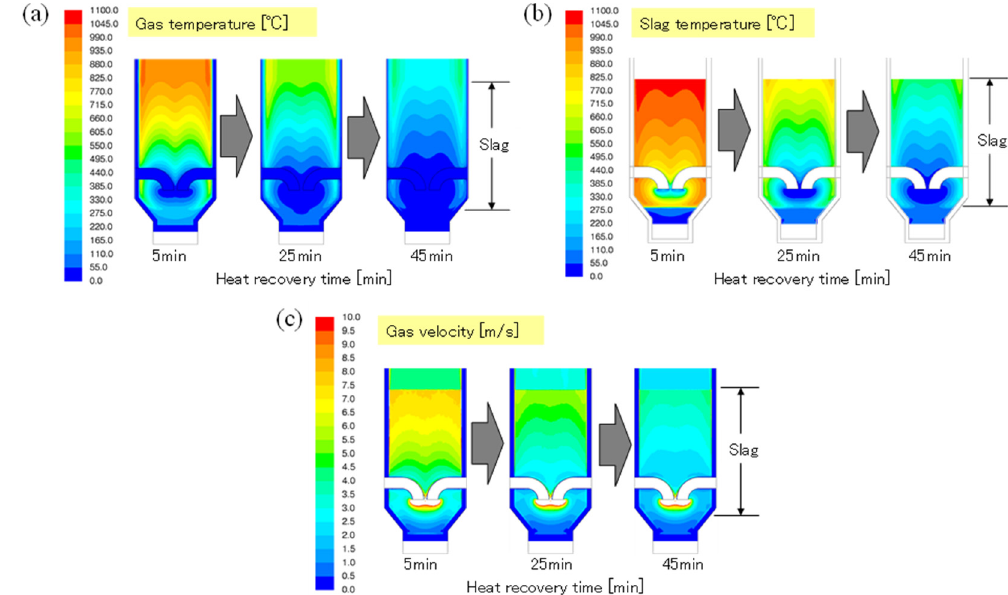
Figure 13. Result of Case 2 simulation: ( a ) gas temperature; ( b ) slag temperature and ( c ) gas velocity.